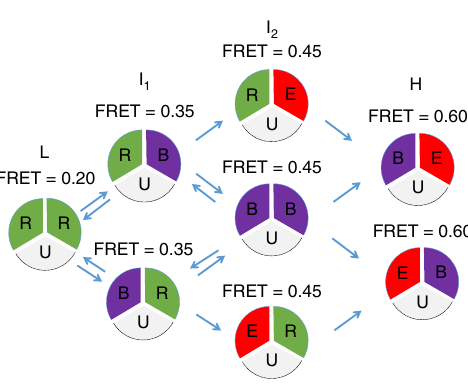
Fig. 6 Proposed model of drug ef fl ux mechanism. On the basis of our experimental data, there are at least four distinct states found in the trimeric CmeB multidrug ef fl ux pump. These four states are labeled as low ( L ), intermediate-1 ( I 1 ), intermediate-2 ( I 2 ), and high ( H ) FRET states, which correspond to ~0.20, ~0.35, ~0.45, and ~0.60 FRET ef fi ciencies. During drug export, each protomer of CmeB autonomously undergoes a sequence of conformational transitions through a particular protomer. This schematic diagram indicates that each protomer within the CmeB trimer can independently go through a sequence of conformational transitions, which lead to the extrusion of substrate ( R resting, B binding, E